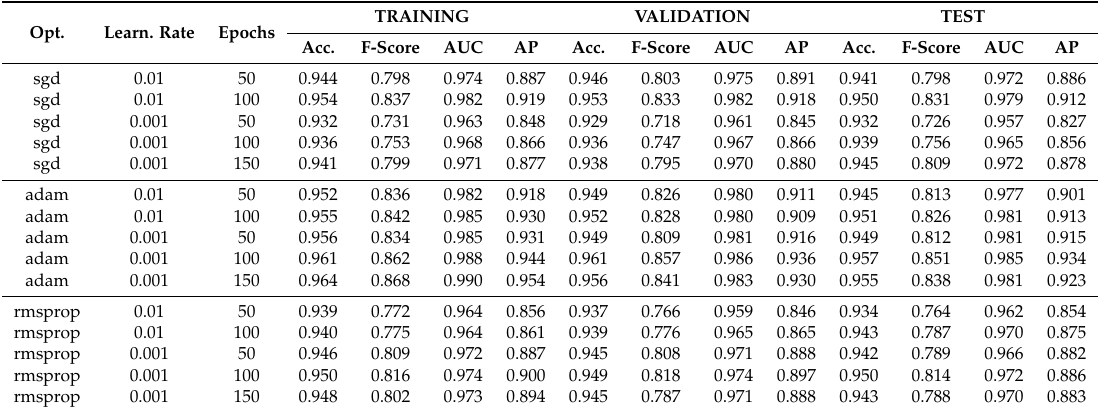
Table 10. Result of different combinations of optimizers, learning rates and epochs for the final Neural Network